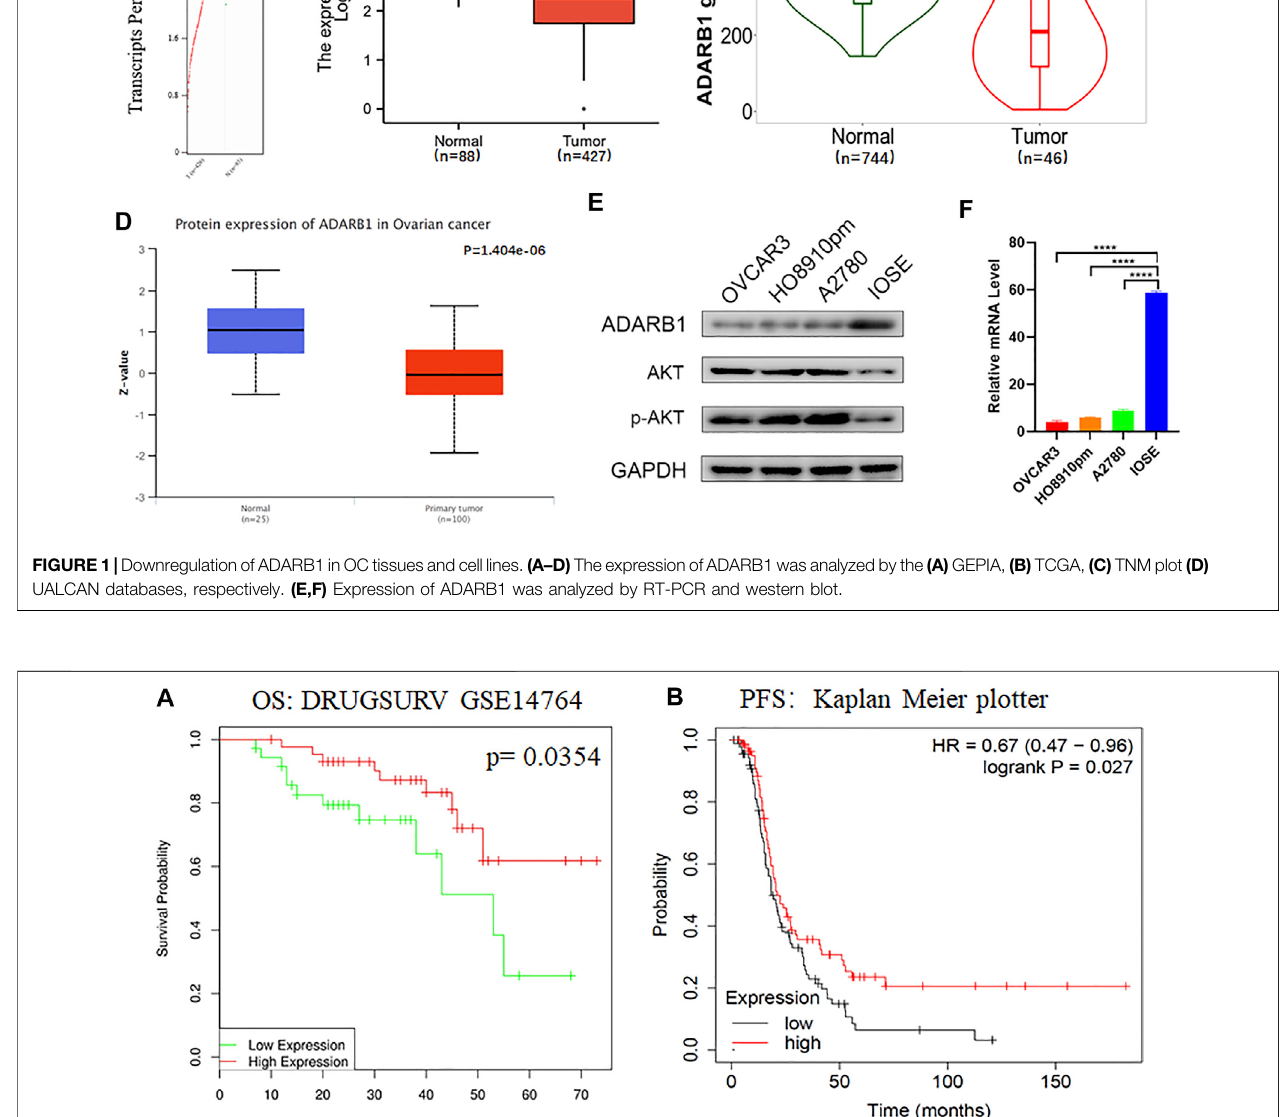
Frontiers in Bioengineering and Biotechnology |